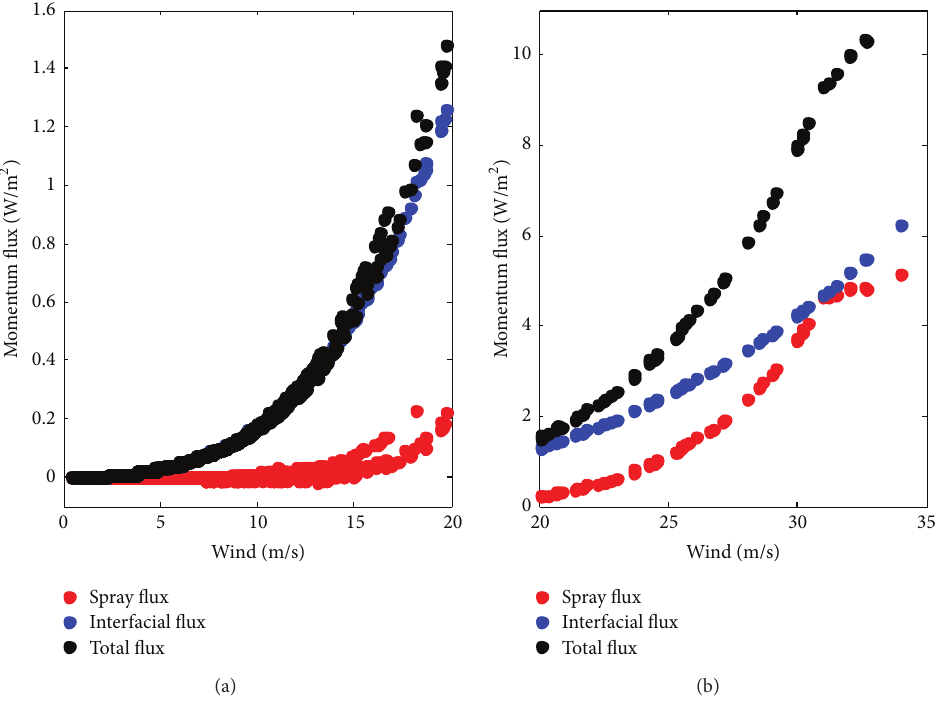
Figure 8: Magnitude of the momentum flux as a function of wind speed for the wind speeds from (a) 0 to 20 m/s; (b) 20 to 35 m/s. (Black dot line, blue dot line, and red dot line represent total momentum flux, interfacial momentum flux, and sea spray momentum flux,